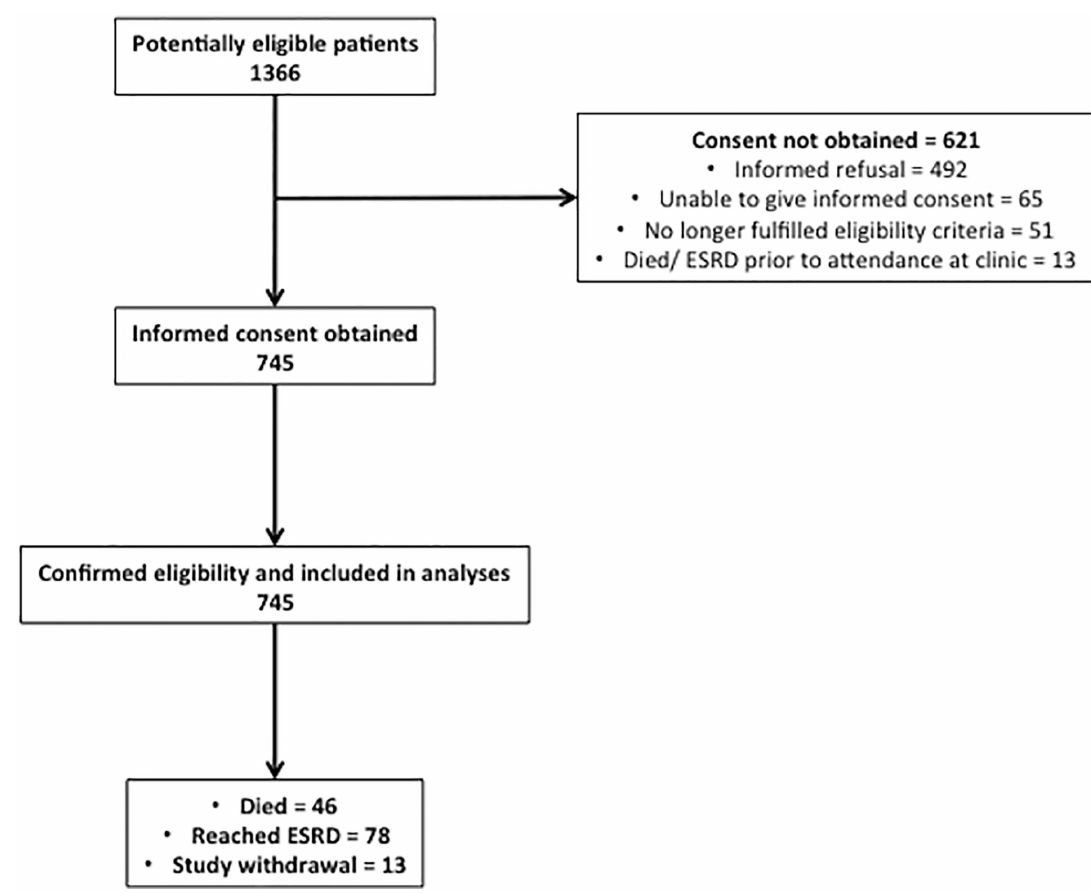
Fig 1. Flow diagram of the participants in the study. ESRD—End-stage renal